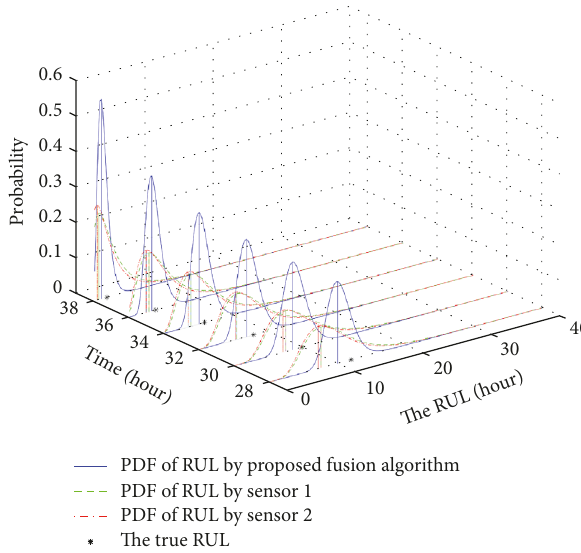
Figure 4: The PDFs of RUL at 36 hours.